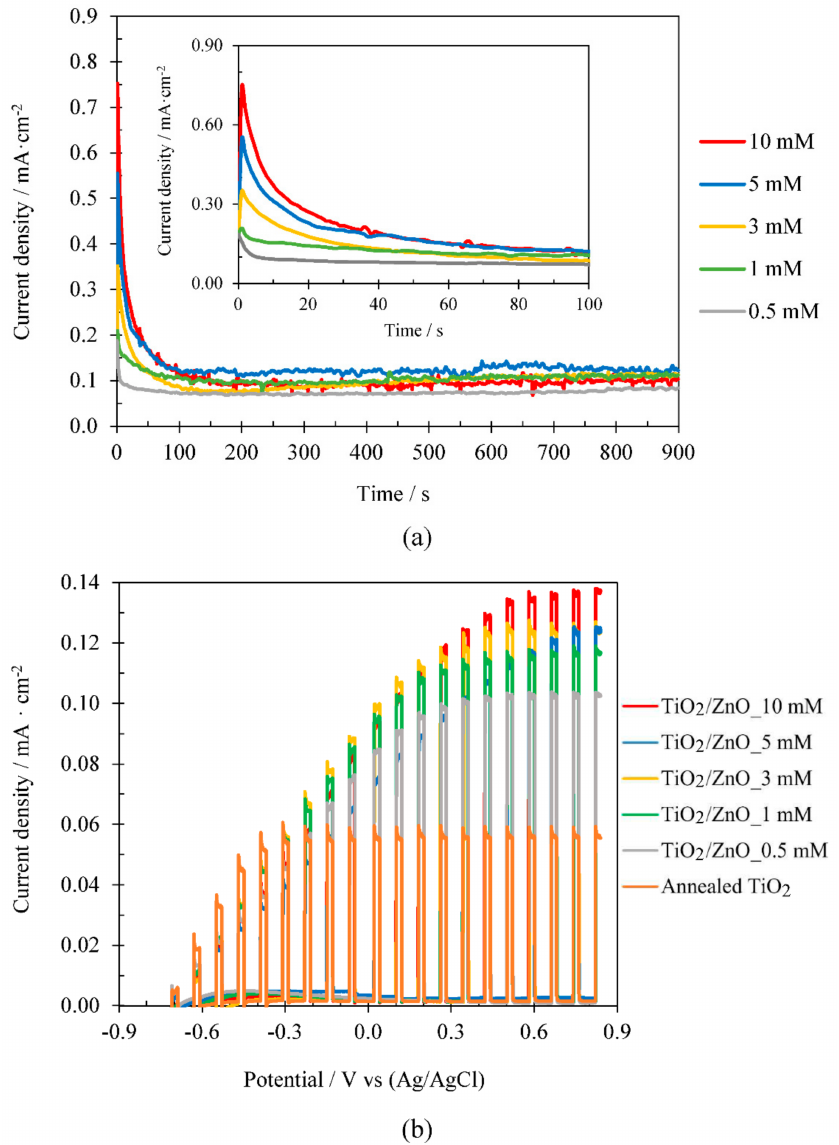
Figure 6. Effect of the Zn(NO 3 ) 2 concentration for TiO 2 /ZnO hybrid nanosponges electrodeposited on crystalline TiO 2 at 75 ◦ C for 15 min: ( a ) during the electrodeposition process, with an insert of the first 100 s, and ( b ) during the photoelectrochemical water splitting tests under dark and illuminated conditions (AM 1.5) (comparison with TiO 2